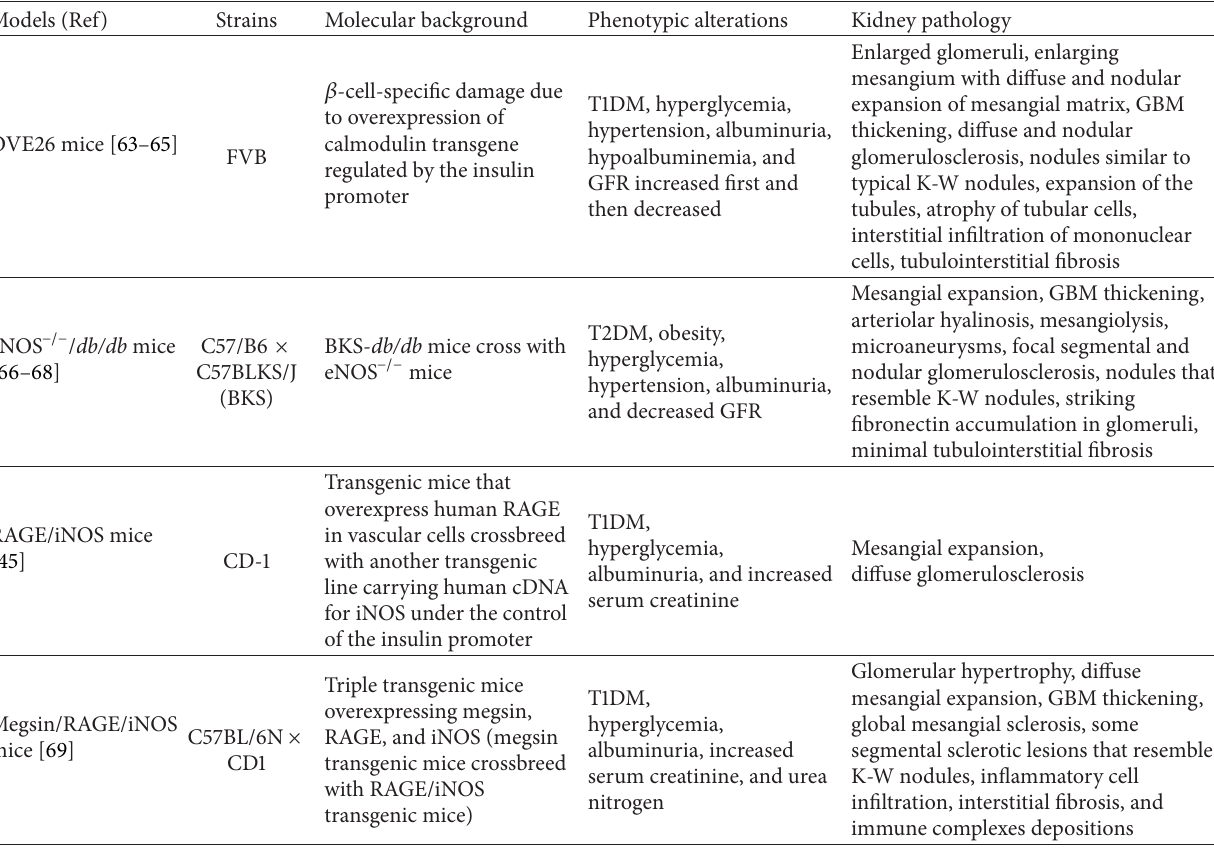
Table 2: Genetically engineered murine models of